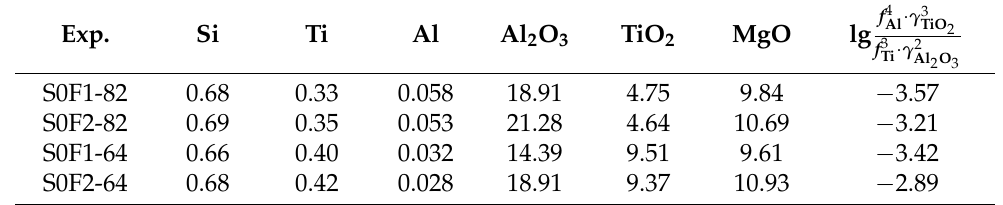
Table 4. The chemical composition of steel and slag after slag-metal reaction experiments (Mass pct).